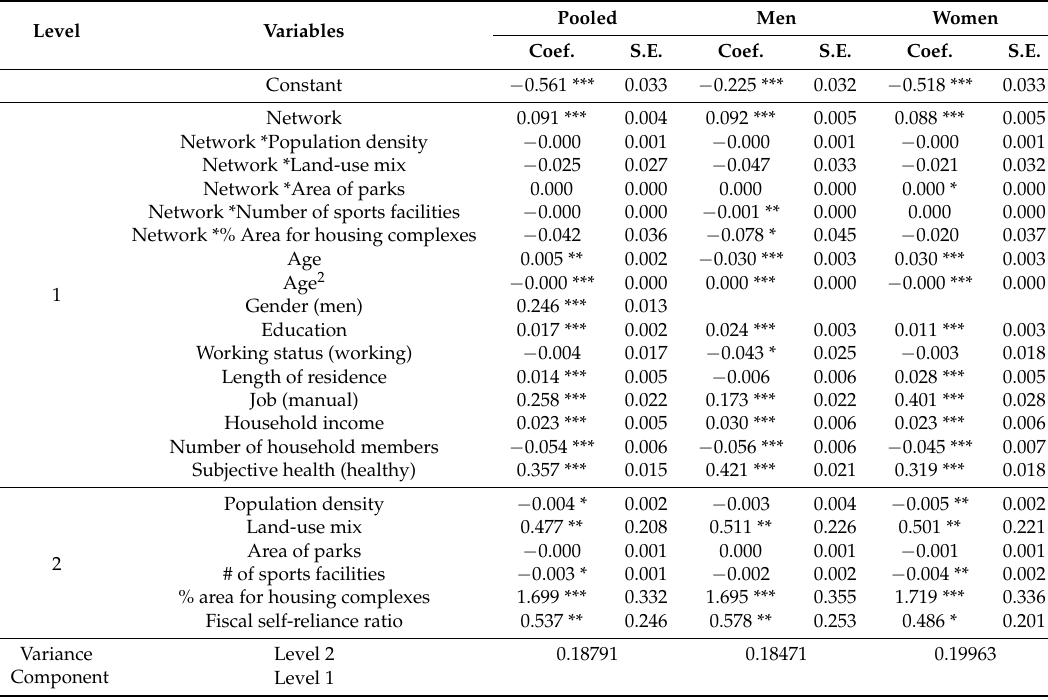
Table 5. Multi-Level Estimates: Network